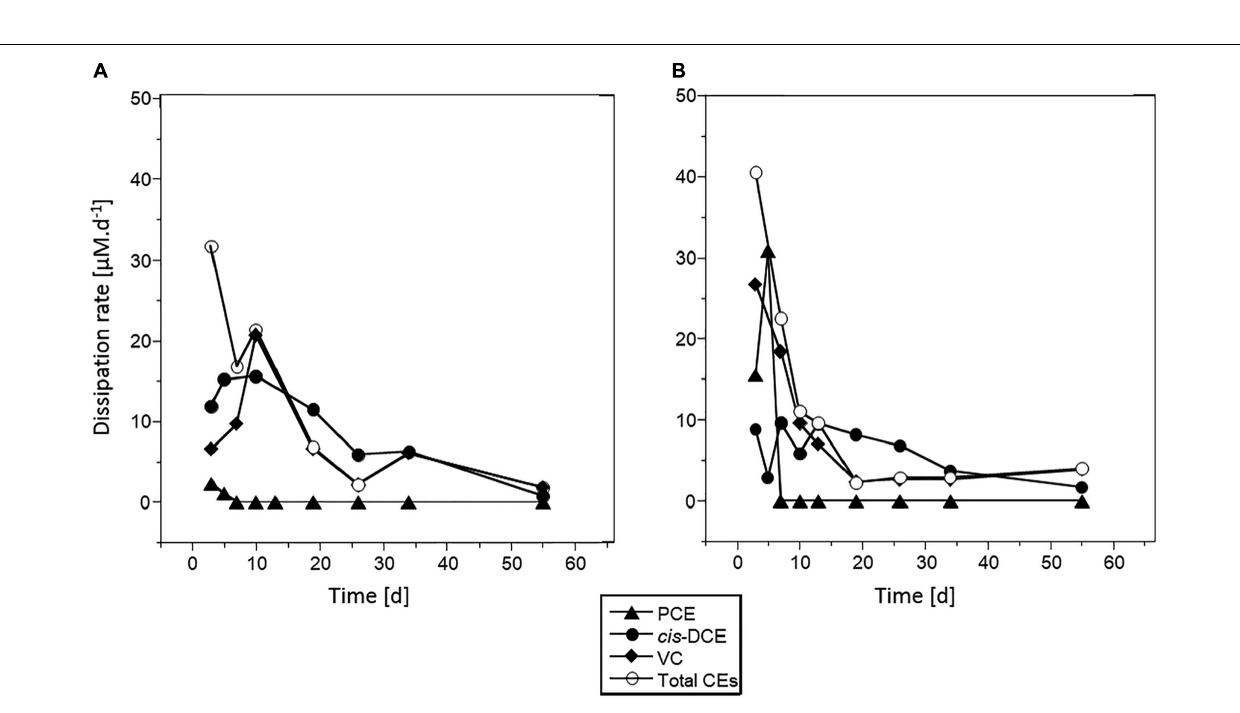
Frontiers in Microbiology |